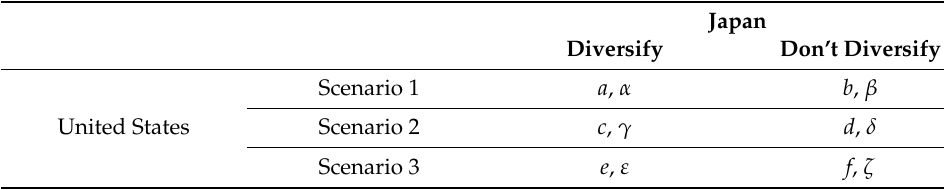
Table 4. Overall payoff matrix for the Japan-U.S. subgame.